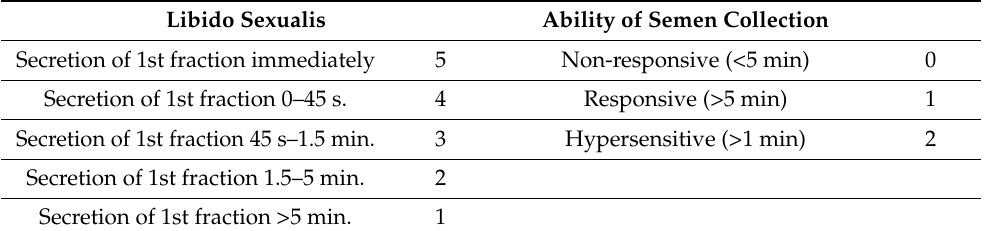
Table 1. The evaluation scale of reproductive behavioral parameters. Libido Sexualis Ability of Semen Collection Secretion of 1st fraction immediately 5 Non-responsive (<5 min) 0 Secretion of 1st fraction 0–45 s. 4 Responsive (>5 min) 1 Secretion of 1st fraction 45 s–1.5 min. 3 Hypersensitive (>1 min) 2 Secretion of 1st fraction 1.5–5 min. 2 Secretion of 1st fraction >5 min.